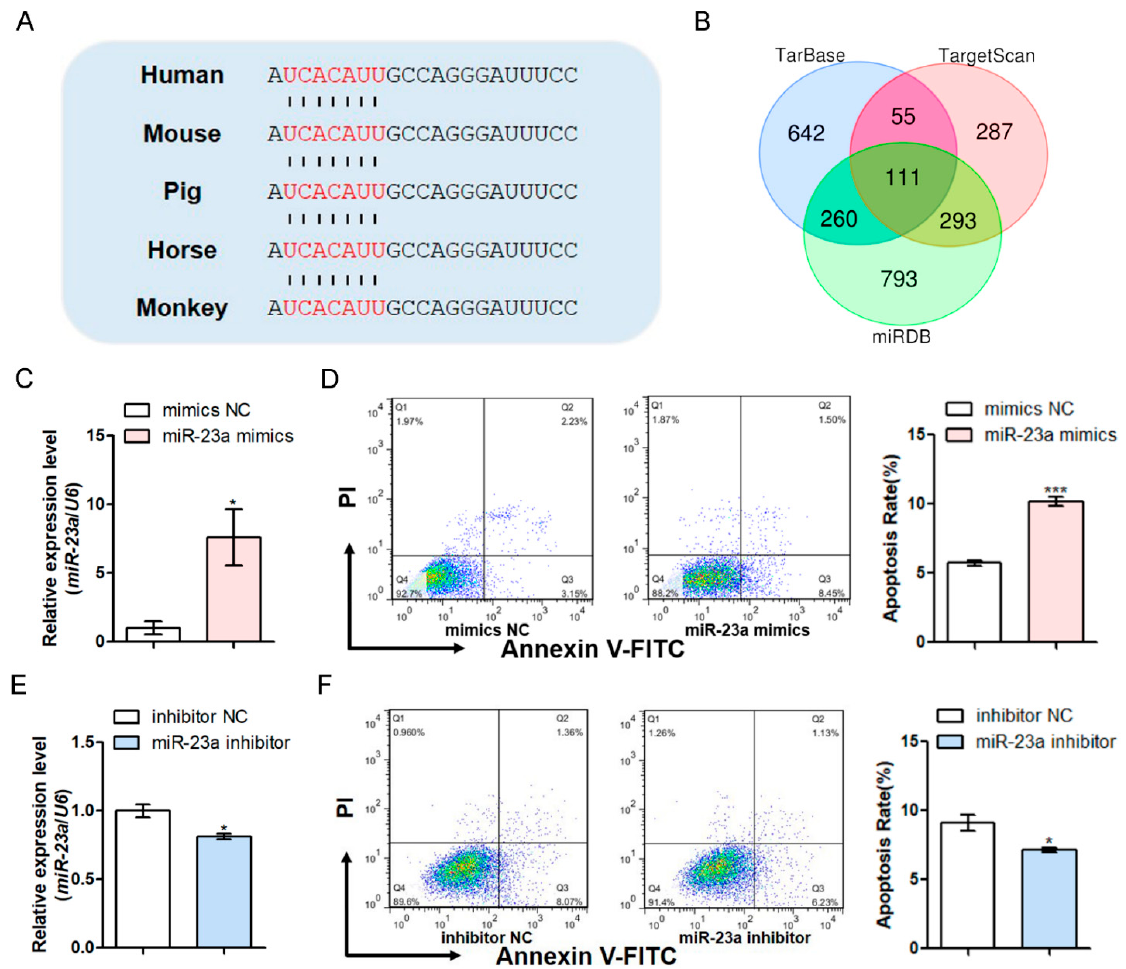
Figure 1. miR-23a induces pGC apoptosis. ( A ) Multiple alignments of the mature sequences of miR-23a in mammals. The bases marked in red are the seed sequence. ( B ) The prediction of potential targets for miR-23a was performed using TarBase (blue), TargtScan (red), and miRDB (green). ( C , D ) After transfection with miR-23a mimics, miR-23a levels were examined by qRT-PCR at 24 h (c), and the apoptosis rate was examined by fluorescence-activated cell sorting (FACS) at 48 h (d) in pGCs. ( E , F ) After transfection with the miR-23a inhibitor, miR-23a levels were examined by qRT-PCR at 24 h ( E ), and the apoptosis rate was examined by FACS at 48 h ( F ) in pGCs. Data are expressed as the mean ± S.E.M., and the significance was tested using a t -test. (* p < 0.05, *** p < 0.001). 3.2. miR-23a Activates the Transcription and Function of lncRNA NORHA Nuclear and cytoplasmic miRNAs have been shown to control cell functions by dif- ferent mechanisms (RNAi or RNAa) [22]. We performed a subcellular localization assay by separating nuclear and cytoplasmic RNA and showed that miR-23a is more enriched in the nucleus than it is in the cytoplasm of pGCs (Figure 2A), indicating that miR-23a induces pGC apoptosis, possibly via an RNAa mechanism. Interestingly, an MRE motif was detected in the promoter region of the porcine NORHA , a pro-apoptotic lncRNA in pGCs (Figure 2B), when we previously analyzed its promoter sequence [19]. Furthermore, the two have a strong potential interaction ability with the -20 kcal/mol of the minimum free energy (MFE) (Figure 2C), so NORHA was selected for further investigation. As ex- pected, we noted that the overexpression of miR-23a significantly activates NORHA tran- scription in pGCs at 48 h, but not at 24 h (Figure 2D), which is in line with the first feature of the RNAa mechanism: delayed action time. Similarly, the knocking down of miR-23a significantly inactivates NORHA transcription in pGCs at 48 h, but not at 24 h (Figure 2E). To investigate whether miR-23a induces pGC apoptosis through the activation of NORHA transcription, both the miR-23a inhibitor and pcDNA3.1- NORHA were co-transfected into pGCs cultured in vitro. The overexpression of NORHA significantly reversed the reduc- tion of the pGC apoptosis rate caused by the miR-23a inhibitor (Figure 2F). In summary, these data suggest that miR-23a enhances pGC apoptosis through the activation of NORHA transcription.